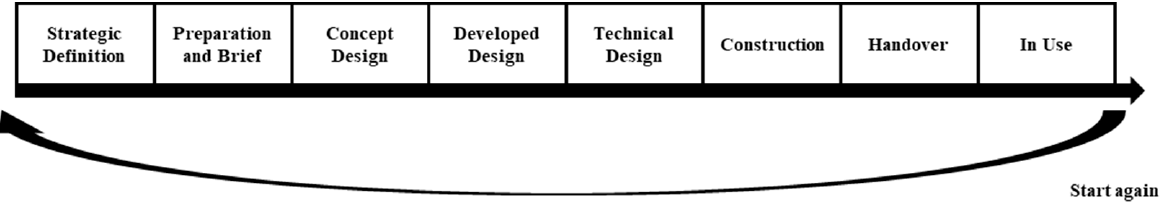
Figure 1. Usability briefing process modified from Fronczek-Munter [5].